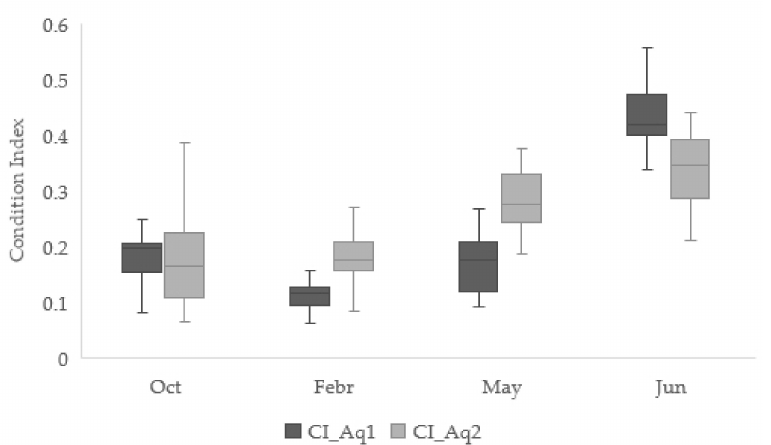
Figure 3. Median condition index (CI) of cultivated mussels ( Mytilus galloprovincialis ) in four seasons for the two fish farms (Aq1: Epidauros and Aq2: Evoikos) from October 2020 until June 2021. Data are expressed as the mean ± standard deviation (n = 30 individuals).